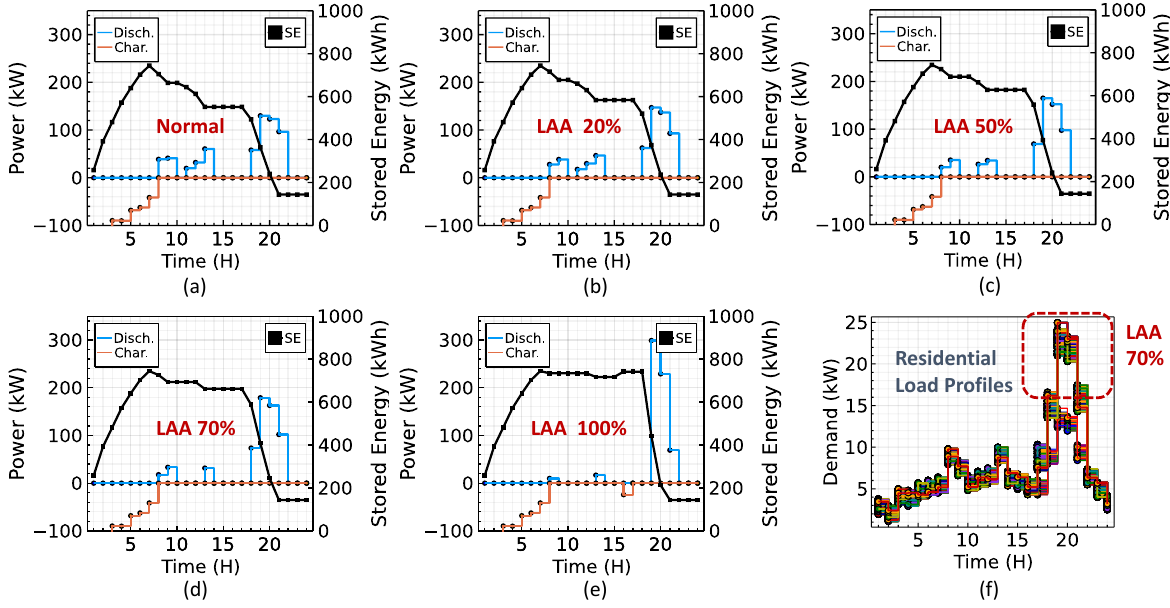
Figure 2. Energy storage (ES) charging and discharging operations for the: ( a ) normal scenario; ( b ) 20% LAA increase scenario; ( c ) 50% LAA increase scenario; ( d ) 70% LAA increase scenario; and ( e ) 100% LAA increase scenario. The blue line represents the discharging operations of the ES system, the orange line represents the charging operations of the ES system, and the black line represents the stored energy of the ES system. ( f ) shows the load profiles for the normal scenario and the 70% LAA scenario where compromised loads have a 70% increase in power consumption during the attack hours (i.e., during the 5 to 9 pm